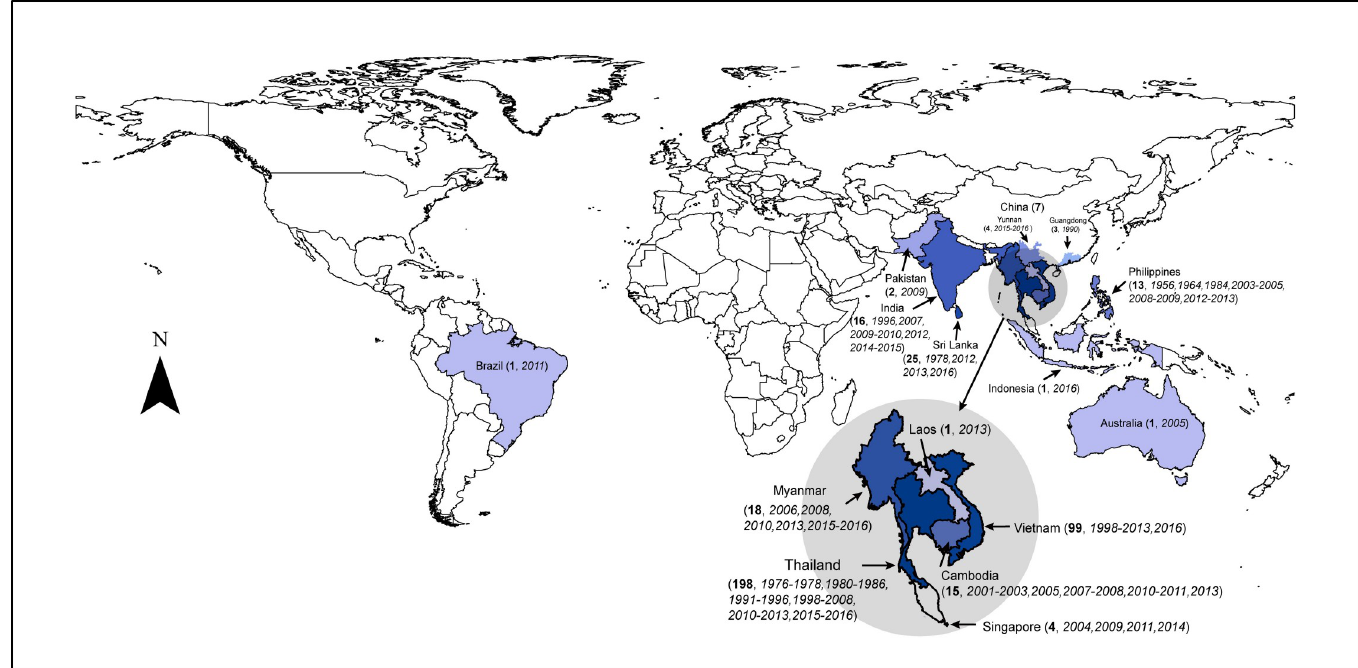
Fig 1. The global distribution of DENV 4-I. The number of unique strains (in bold, < 100% similarity in the same year) and the years of recorded transmission (in italic) in each location are shown in parenthesis after each location name.